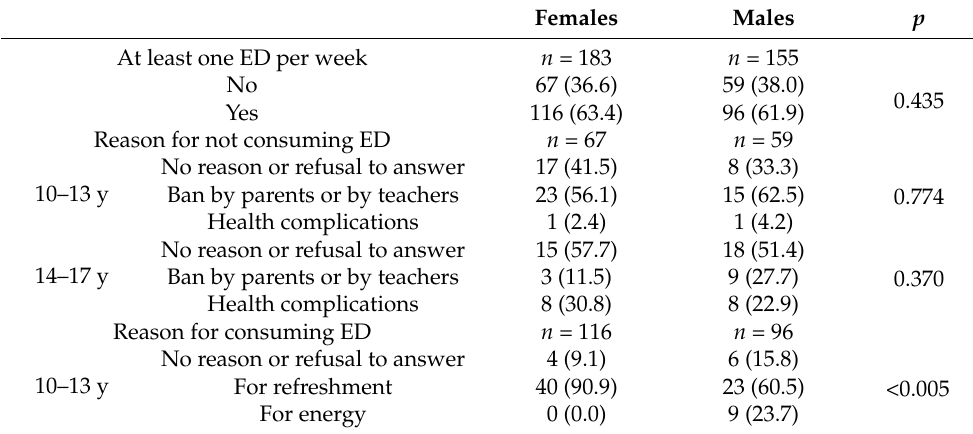
Table 3. Reported consumption of energy drinks (EDs) among female and male pupils participating in a questionnaire survey carried out from 30 May to 7 June 2019 in five schools in Lubumbashi, DR